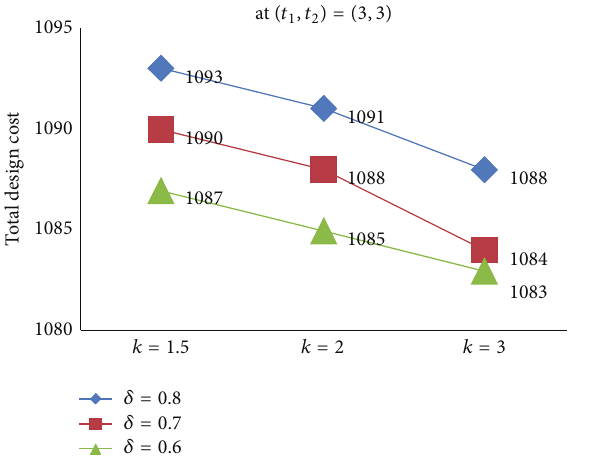
Figure 9: Variation of total design cost with 𝑘 for various 𝛿 values.